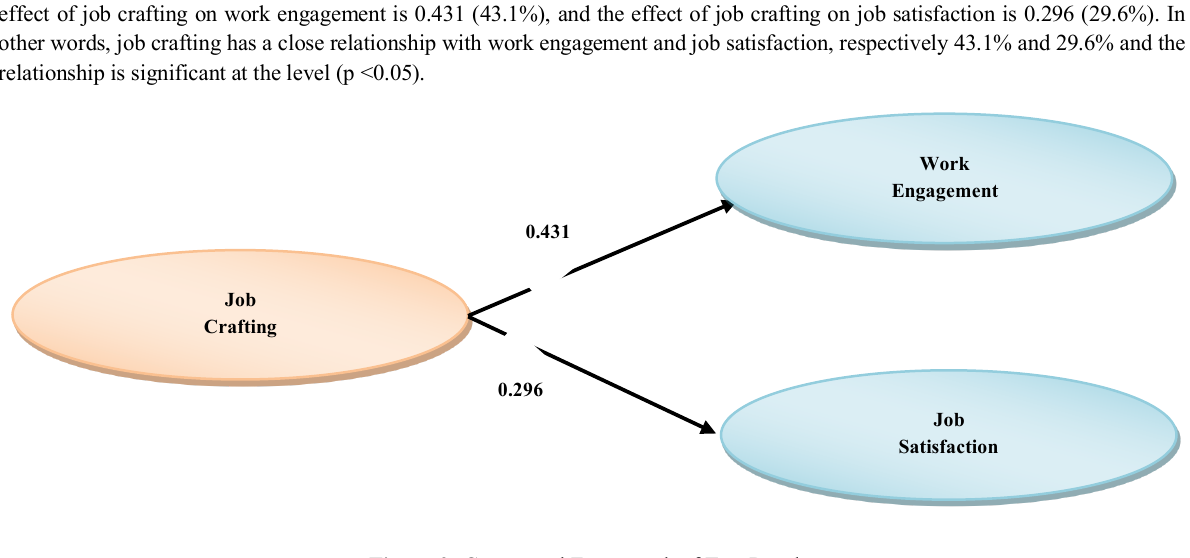
Figure 2: Conceptual Framework of Test